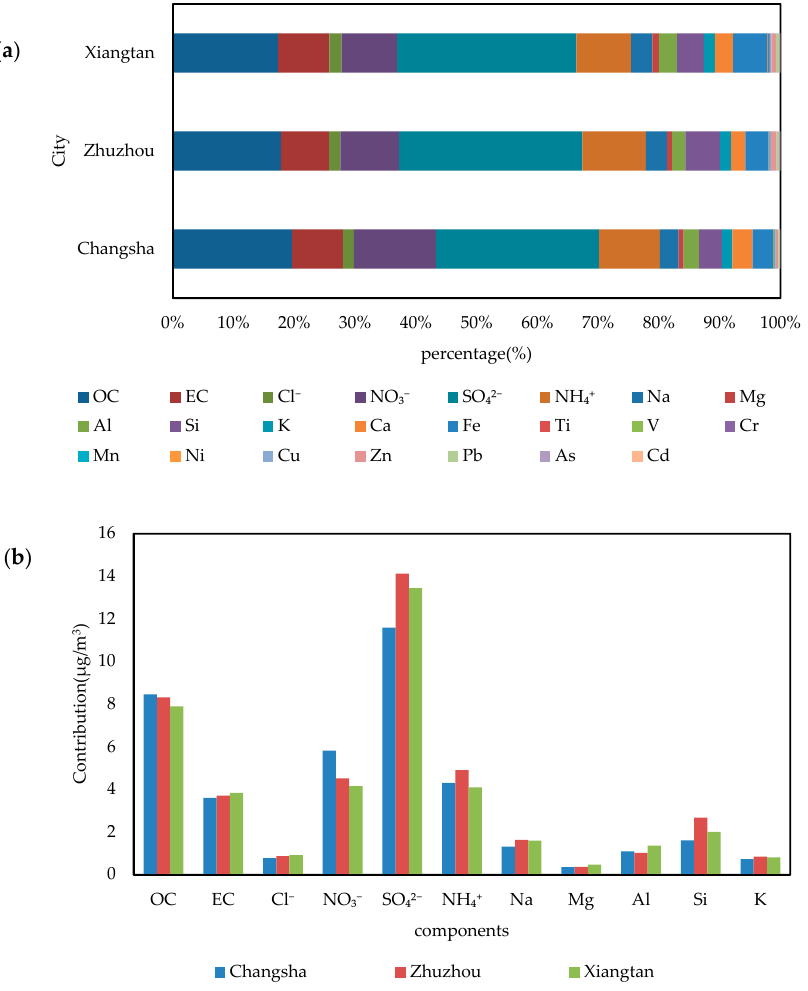
Figure 5. PM 2.5 speciation by cities. ( a ) The percentage of 23 components of PM 2.5 in different regions. ( b ) PM 2.5 main component concentration in different regions ( μ g/m 3 ).